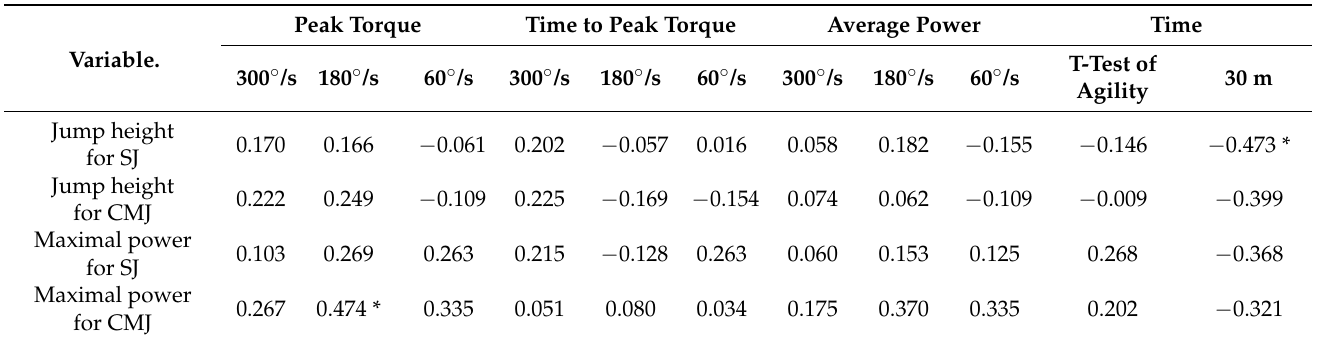
Table 2. Correlation coefficients for the relationships between jump height, maximal power vs. peak torque, time to peak torque, and average power for the knee extensors as well as jump height, maximal power vs. time for T-Test of Agility, and time for 30 m sprint.